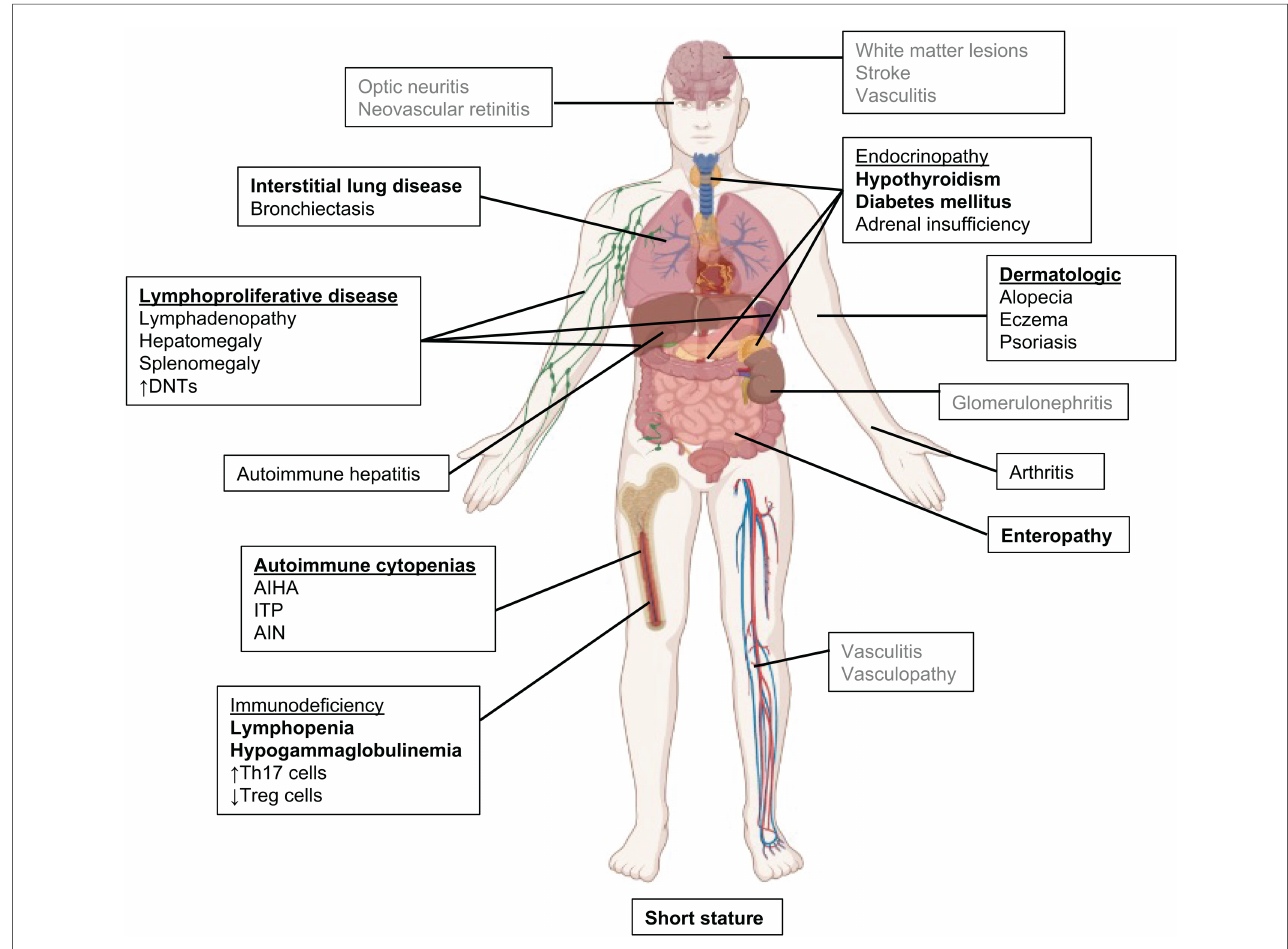
FIGURE 2 Clinical manifestations in STAT3 GOF syndrome. The most common features are in bold, rarely reported features are in